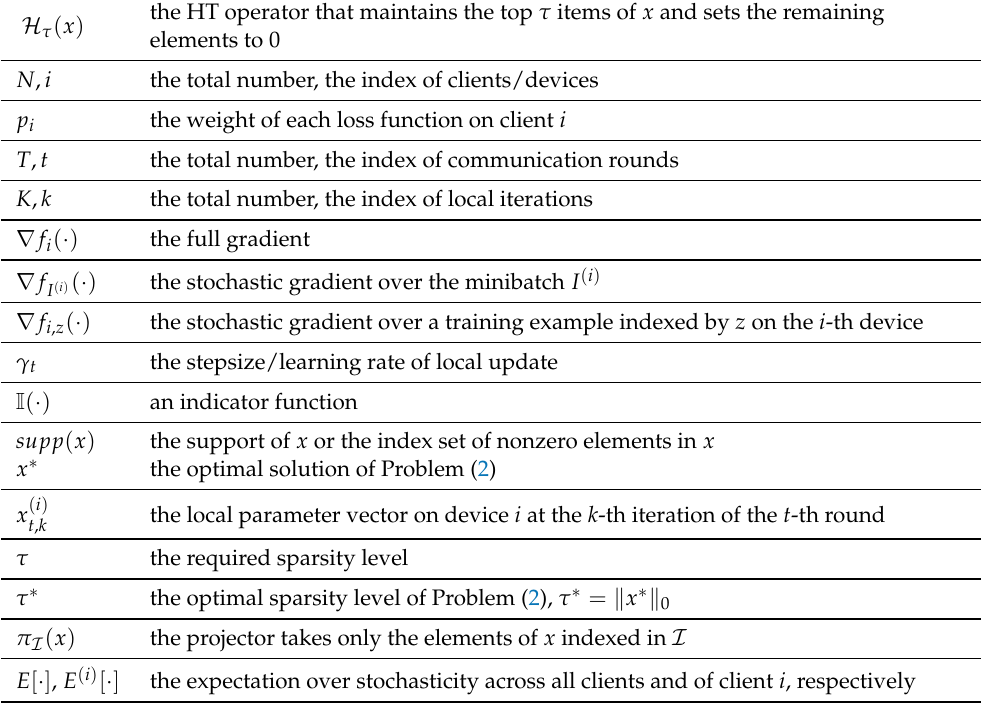
Table 1. Brief summary of notations in this